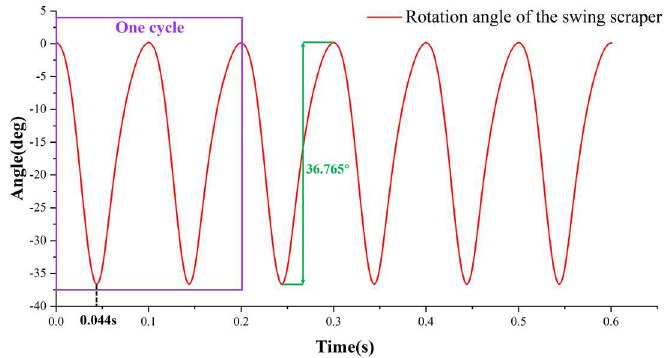
Figure 6. The curve of the rotation angle of the swing scraper.